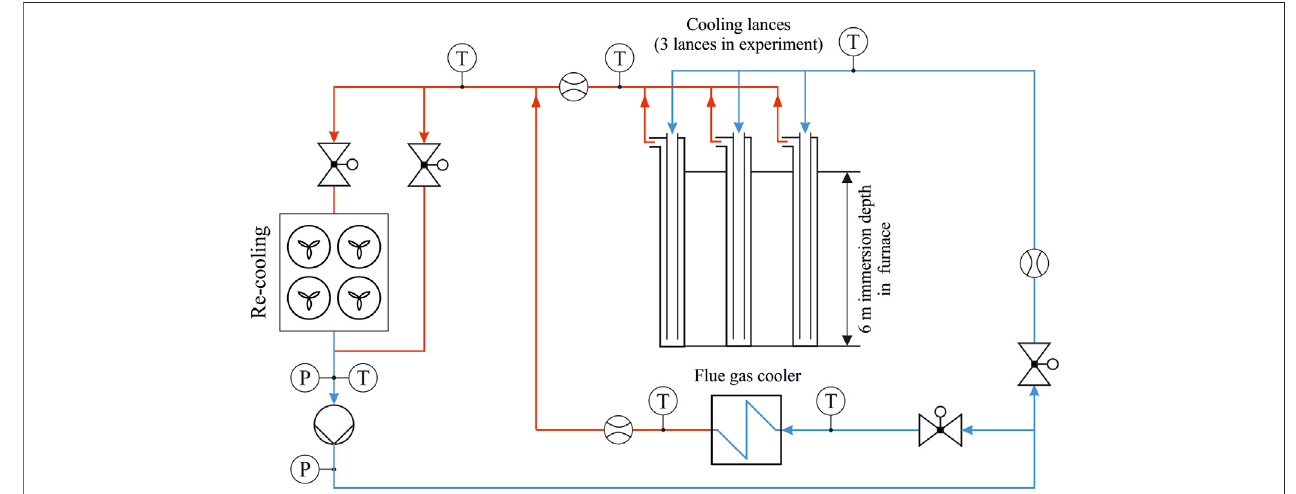
FIGURE 2 | Flow scheme of the cooling system.